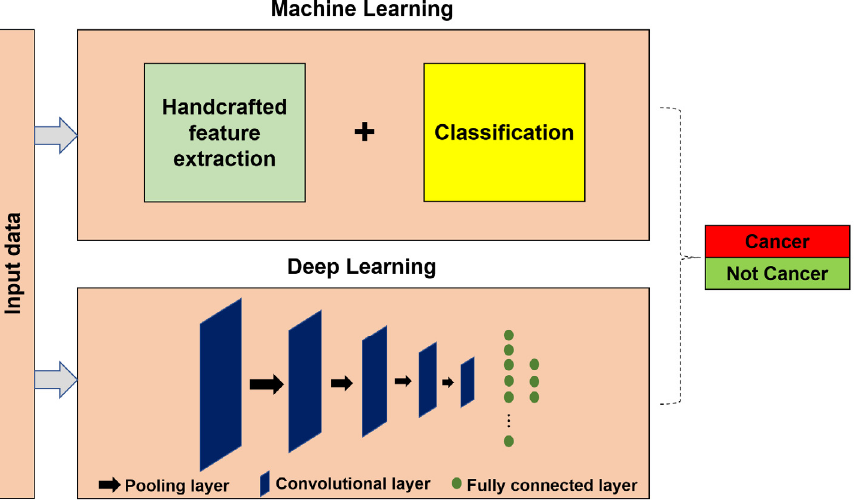
Figure 1. Block diagram showing the fundamental difference between working mechanisms of ML and DL algorithms for classifying images as cancer or non-cancer subtypes.